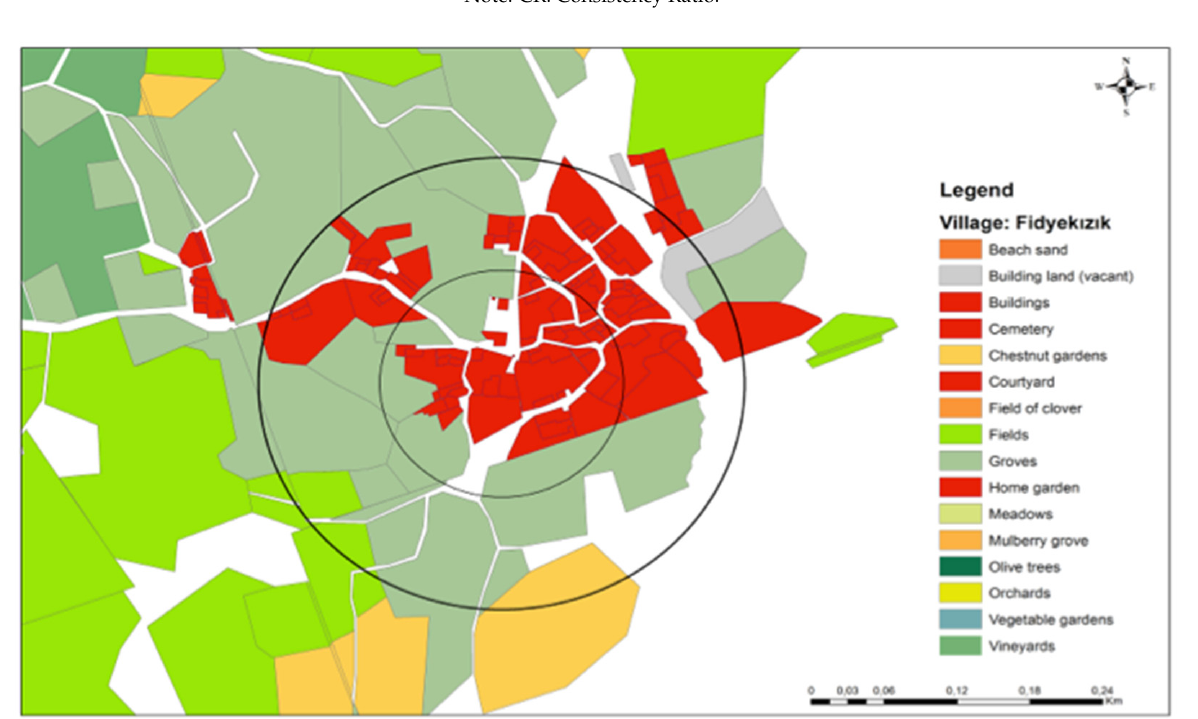
Figure A1. An example of residential development zones in Fidyekızık, Bursa, 185. Source: Turkish Presidency